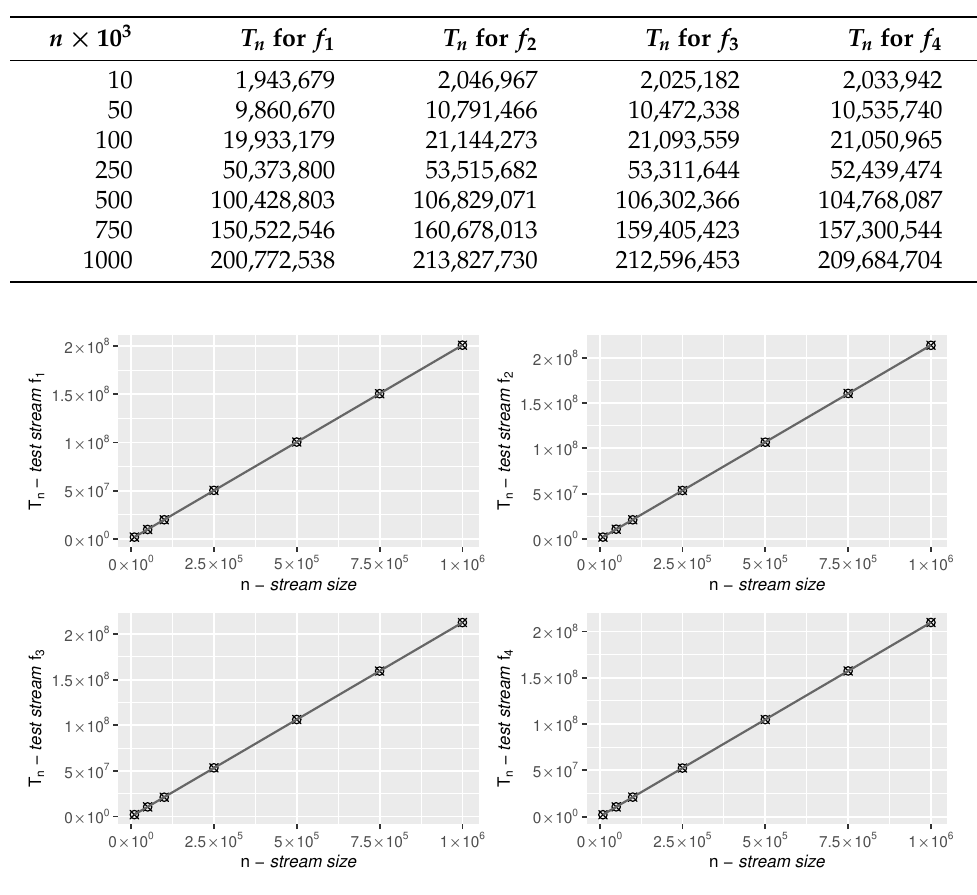
Table A1. The algorithm time complexity analysis: T n —measured in terms of the number of represen- tative operations needed to solve Equation (14)—for different sizes ( n ) of the test streams ( f 1 , f 2 , f 3 , and f 4 ).